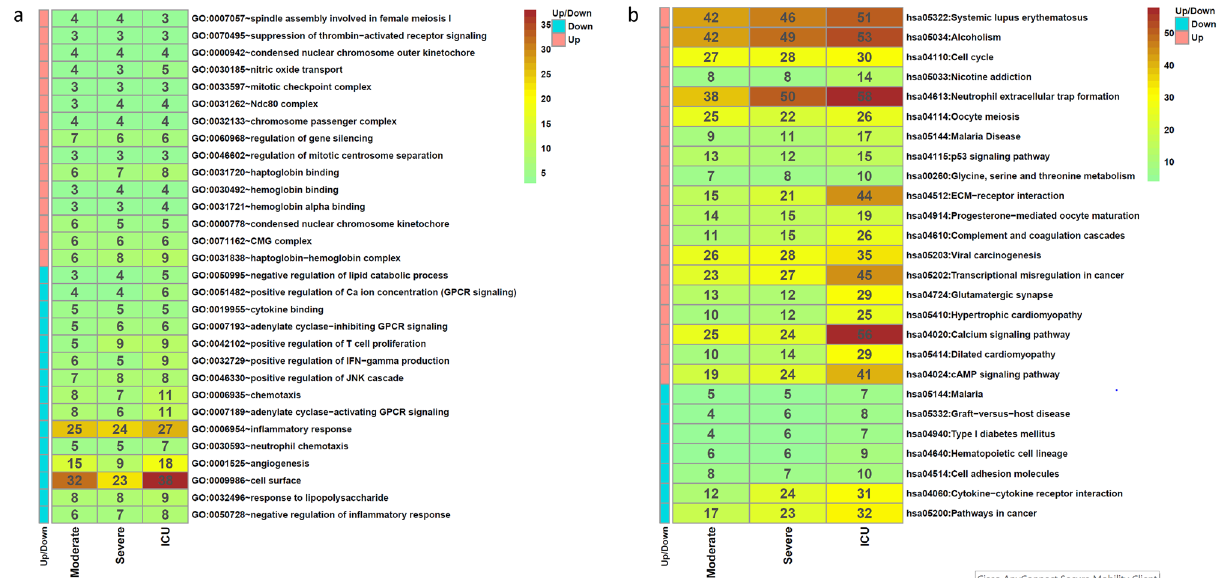
Figure 2. Heatmap of ( a ) gene ontology (GO) terms and ( b ) biological pathways enriched during moderate, severe and extremely severe (ICU) COVID-19. The values in each box of the heatmap represents fold enrichment of the GO terms and pathways for moderate vs. healthy, severe vs. healthy and extremely severe (ICU) COVID-19 infection vs. healthy. The upregulated and downregulated pathways are indicated by the color bar at the left of heatmap. The heatmaps were generated using the ‘pheatmap’ (version 1.0.8) 81 package of R (version 4.0.0) 82 available at http:// cran. nexr. com/ web/ packa ges/ pheat map/ index.